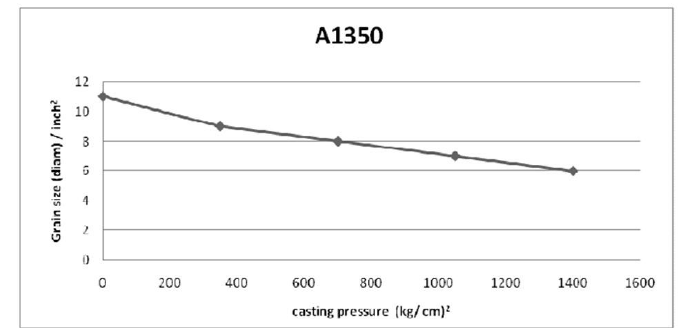
Figure 10. Average grain diameter as a function of pressure for A1350 aluminum alloy 13 .